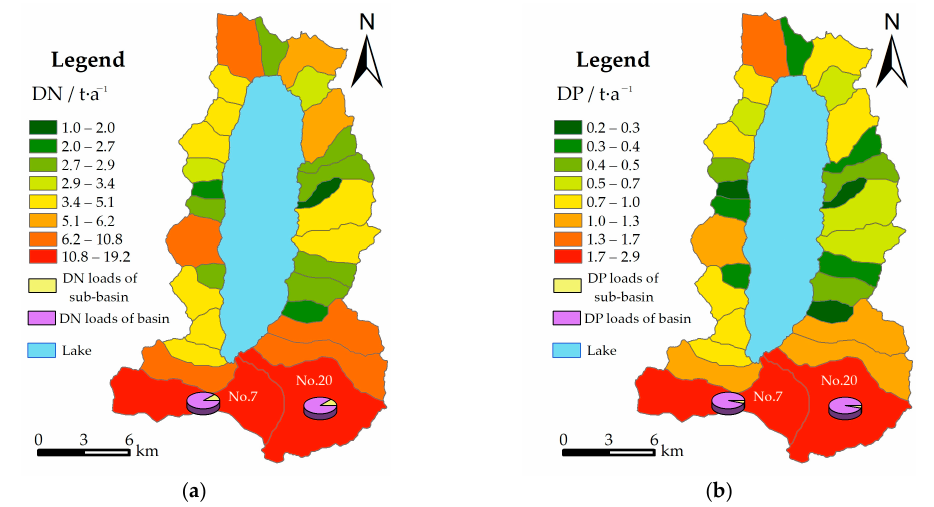
Figure 9. Spatial distribution of ( a ) DN and ( b ) DP loads discharged into Lake Chenghai. Table 4. Loads and contribution percentages of DN and DP from the different portions of the Lake Chenghai watershed.